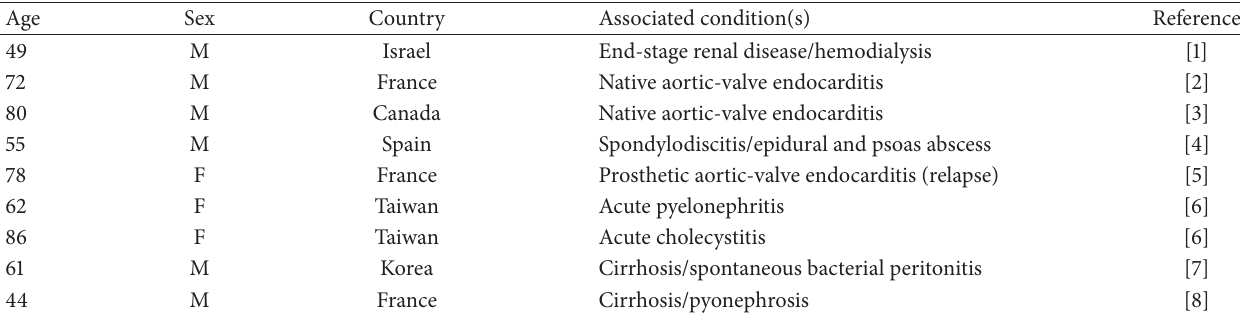
Table 1: Published cases of human Enterococcus hirae